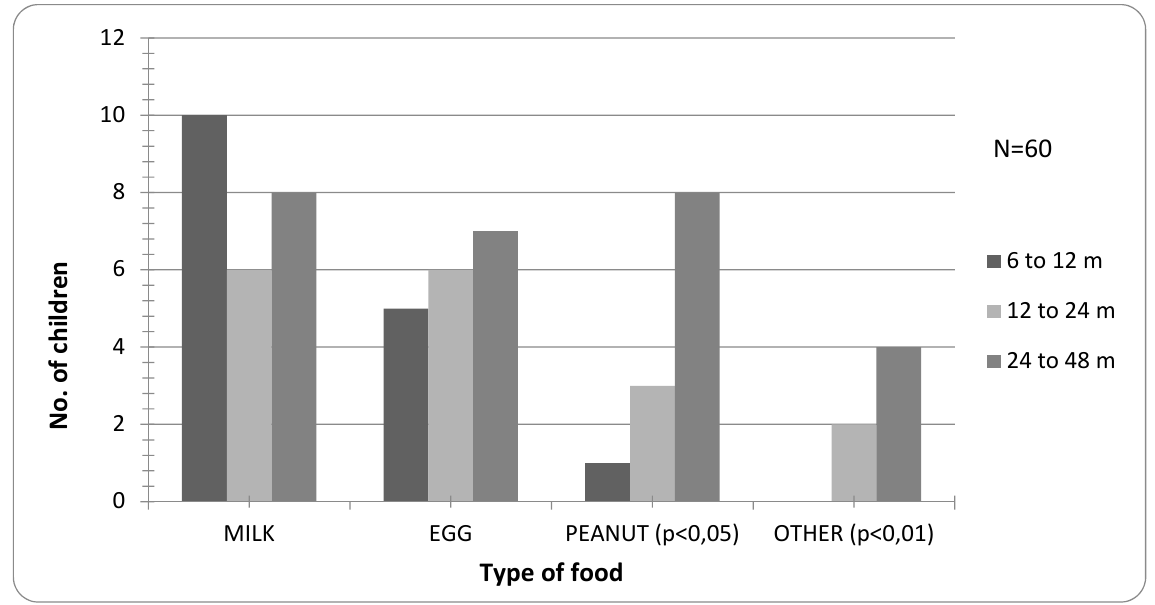
Figure 5. Prevalence of confirmed allergy according to the type of food and